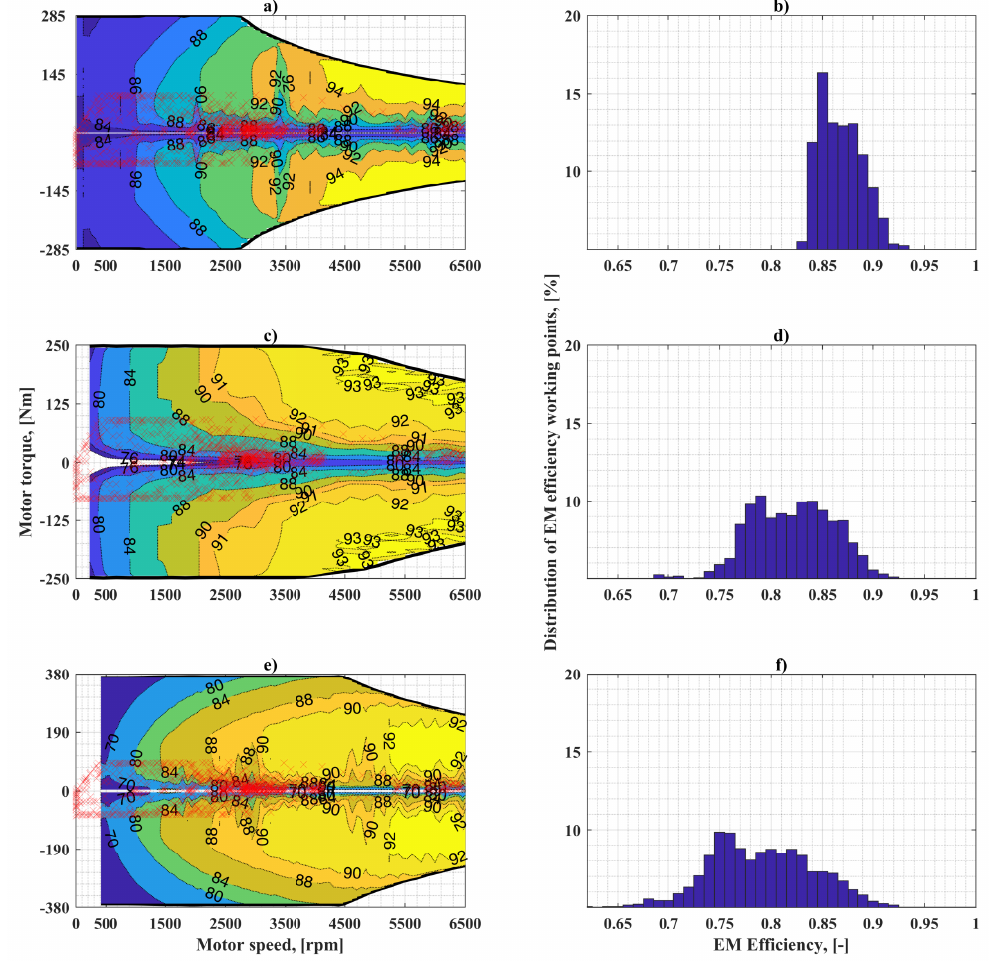
Figure 9. Working points during the UDDS cycle with different EMs installed on Kia Soul BEV). Real characteristics to Kia Soul EM: ( a ) Kia Soul; ( c ) BMW i3; ( e ) YASA EM; and Distribution of real characteristics EMS working points: ( b ) Kia Soul; ( d ) BMW i3; ( f ) YASA